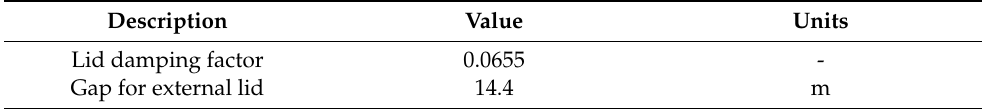
Table 2. Input parameters for the external lid.